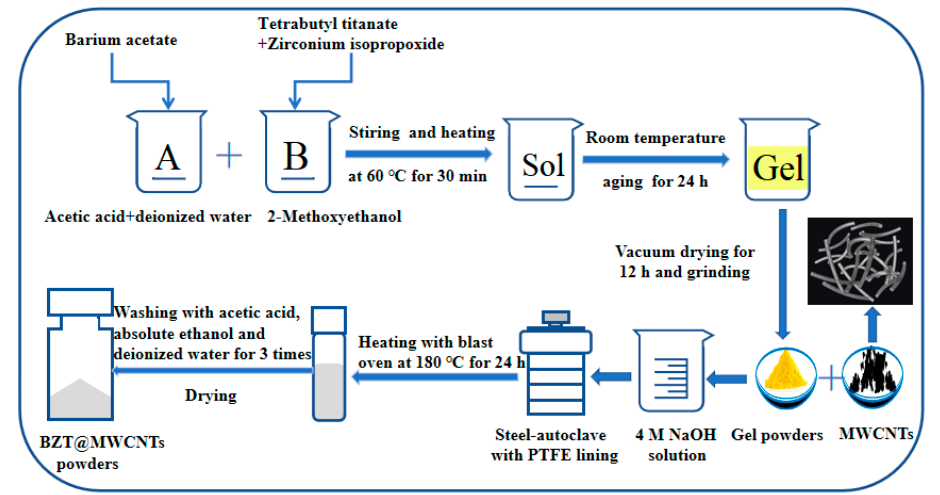
Figure 1. Preparation of Ba(Zr 0.2 Ti 0.8 )O 3 -coated multiwalled carbon nanotubes (BZT@MWCNTs)